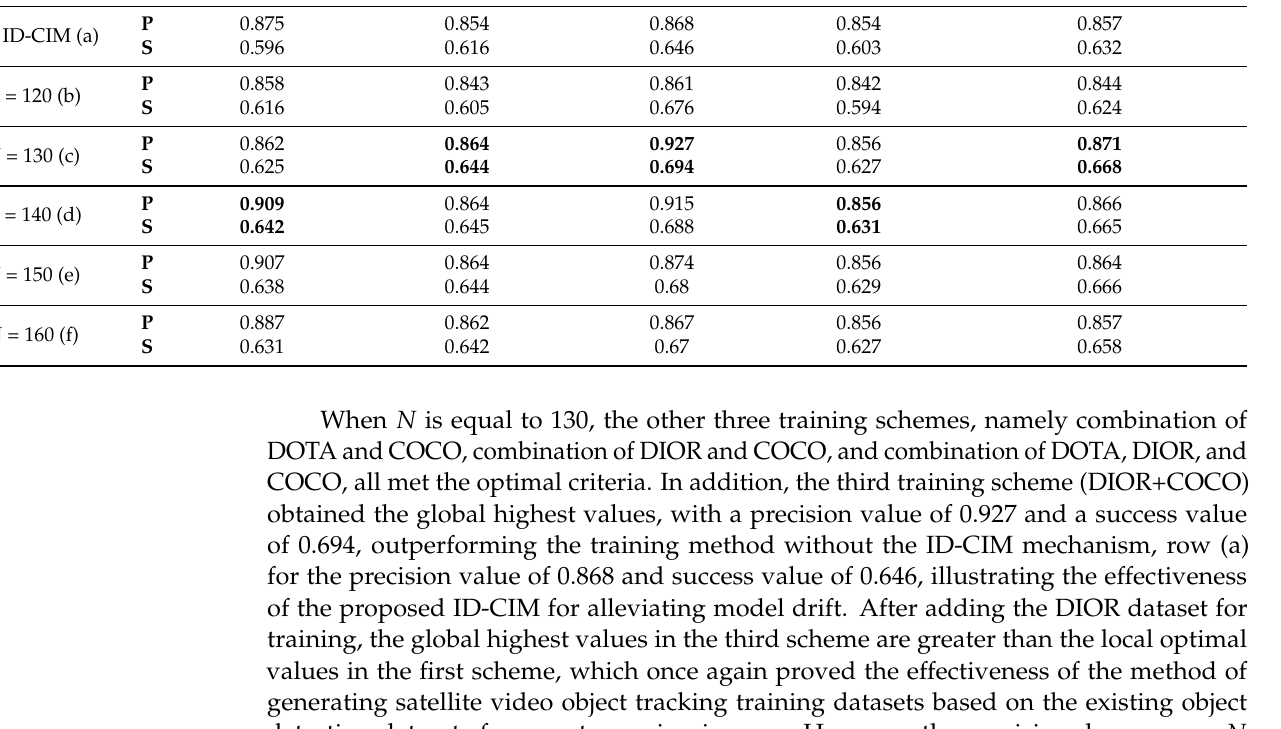
Table 4. The influence of value N on the experimental results of alleviating model drift. COCO DOTA + COCO DIOR + COCO DOTA + DIOR DOTA + DIOR